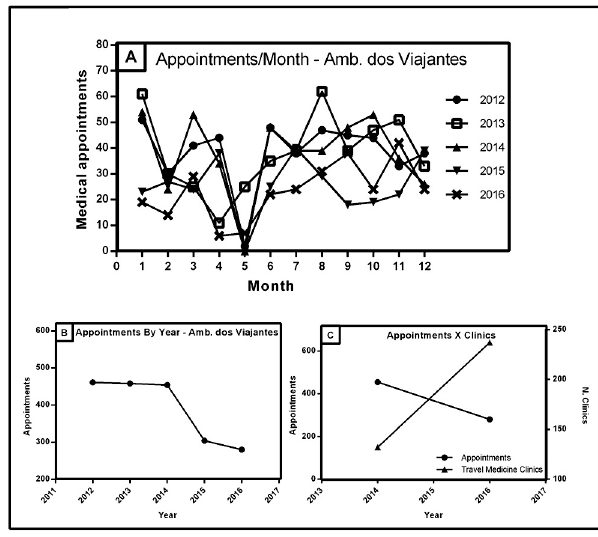
ّ Figure 1. Appointments From 2012 to